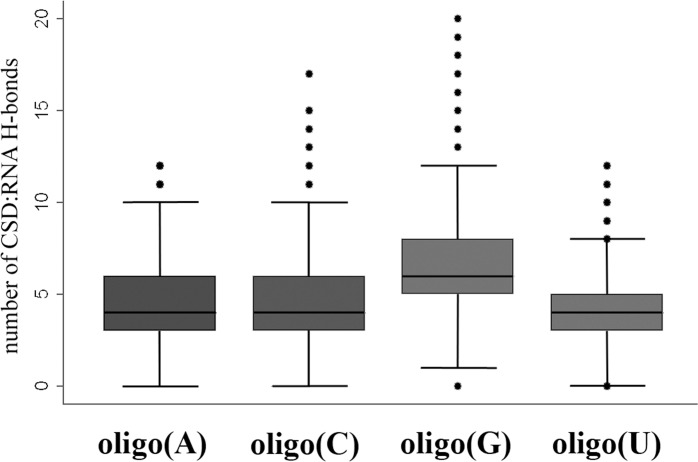
Number of intermolecular H-bonds in the complexes of CSD with different ribooligonucleotides.